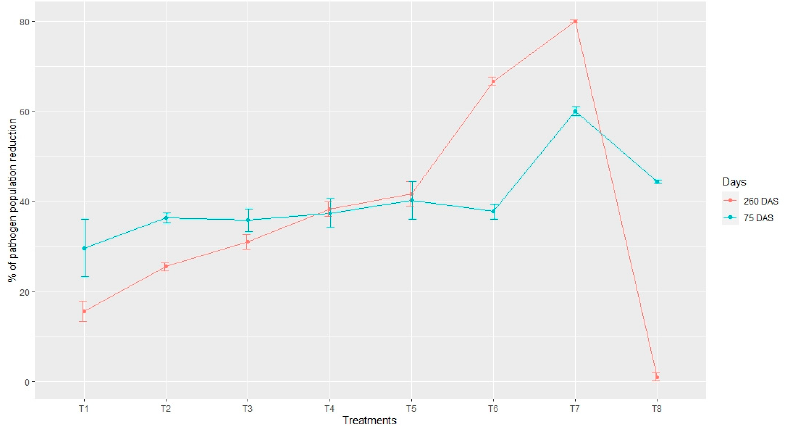
Figure 2. Percentage reduction of population of Fusarium oxysporum by treatments T 1 to T 8 , compared with control treatment (T 9 ) at 75 and 260 days after sowing (DAS). T 1 = Bacillus stratosphericus at 1 × 10 9 cfu/mL; T 2 = B. pumilus at 1 × 10 9 cfu/mL; T 3 = B. subtilis at 1 × 10 9 cfu/mL; T 4 = Pseudomonas aeruginosa at 1 × 10 9 cfu/mL; T 5 = P. putida at 1 × 10 9 cfu/mL; T 6 = P. fluorescens at 1 × 10 9 cfu/mL; T 7 = Trichoderma asperellum at 1 × 10 8 cfu/mL; and T 8 = carbendazim 50 WP at 0.2%. Table 2. Colony forming units (CFUs) recovering of Fusarium oxysporum in saffron field at different days after sowing (DAS). T 1 = Bacillus stratosphericus at 1 × 10 9 cfu/mL; T 2 = B. pumilus at 1 × 10 9 cfu/mL; T 3 = B. subtilis at 1 × 10 9 cfu/mL; T 4 = Pseudomonas aeruginosa at 1 × 10 9 cfu/mL; T 5 = P. putida at 1 × 10 9 cfu/mL; T 6 = P. fluorescens at 1 × 10 9 cfu/mL; T 7 = Trichoderma asperellum at 1 × 10 8 cfu/mL; T 8 = carbendazim 50 WP at 0.2%; and T 9 = water (control). ± is the standard error of the mean of Fusarium oxysporum (cfu / g). * Means followed by the same letter do not significantly di ff er ( p < 0.05) with